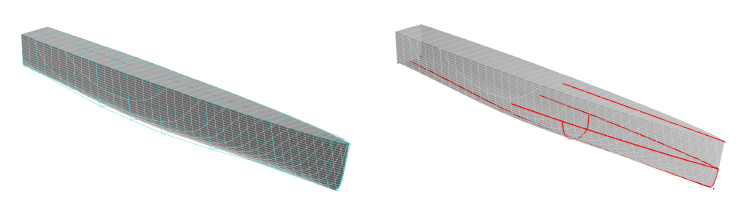
Figure 6. Polyhedron of the Brep and RBF source curves.